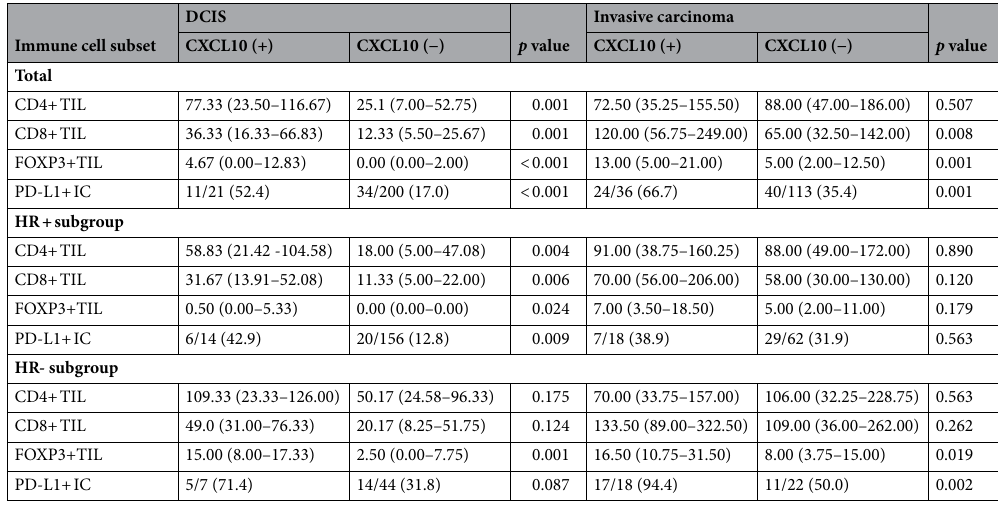
Table 2. Comparison of immune cell subset infiltration in relation to CXCL10 expression in DCIS and invasive carcinoma. P values are calculated by Mann–Whitney U test. Data are shown in are presented as median (interquartile range) for CD4+, CD8+, and FOXP3+ tumor infiltrating lymphocyte (TIL) subsets and frequency (%) for PD-L1+ immune cell